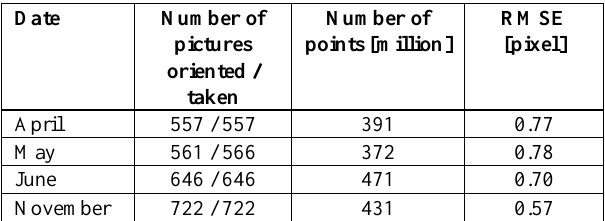
Table 2. Photogrammetric models